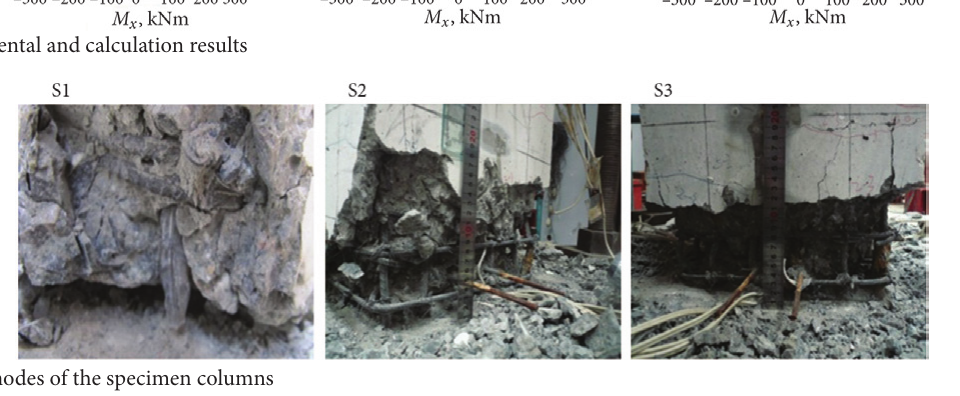
Fig. 11. Failure modes of the specimen columns